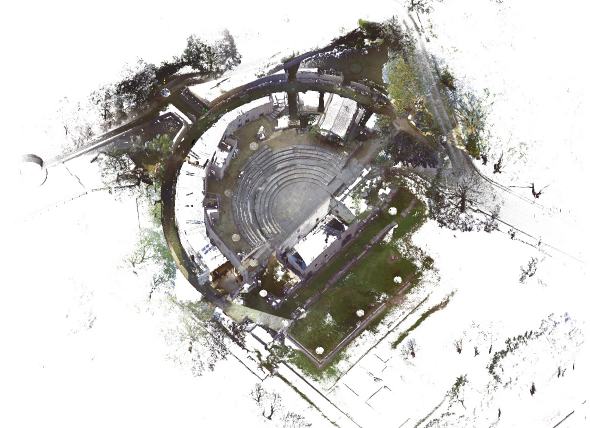
Figure 8. Point clouds of the Saepinum 's